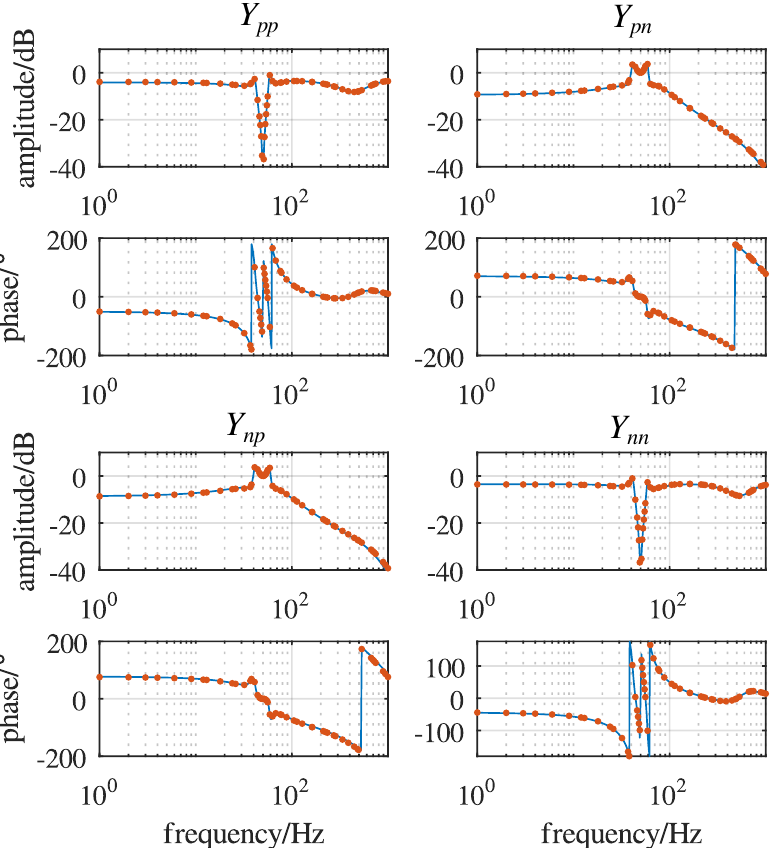
Figure 5. Bode diagram of a WT admittance model. Lines: analytic results; Dots: simulation